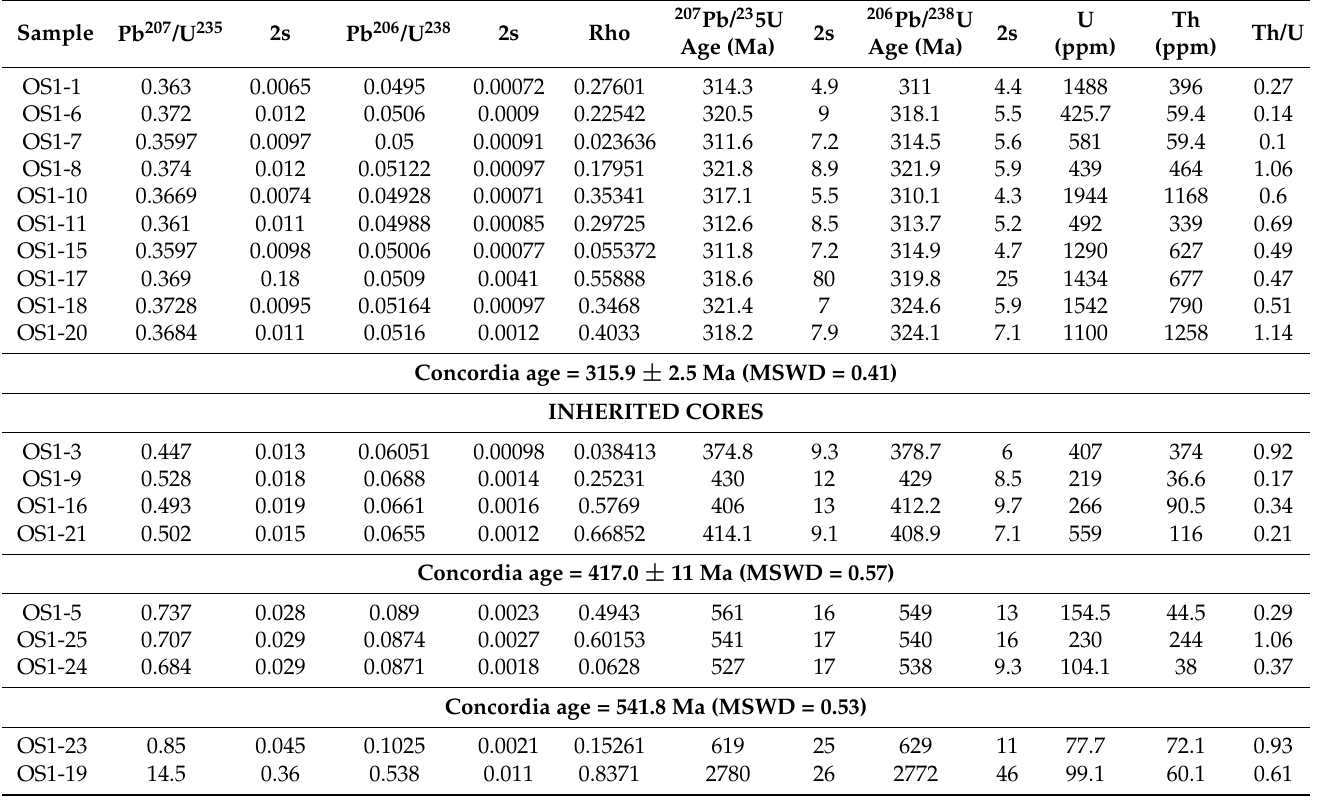
Table 5. U-Pb zircon data from the exotic crystalline block from